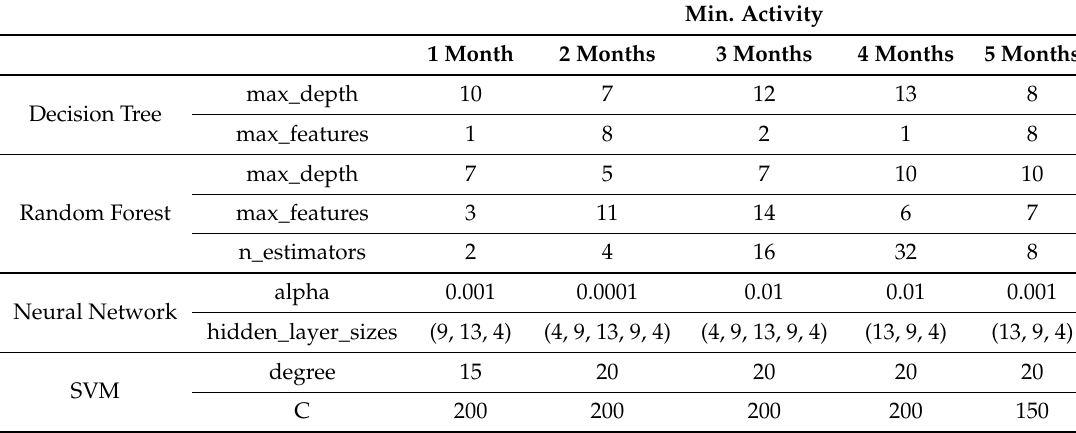
Table A23. The best values of the hyperparameters for the models which uses the full set of features for the manufacturing company dataset with three hierarchy levels.